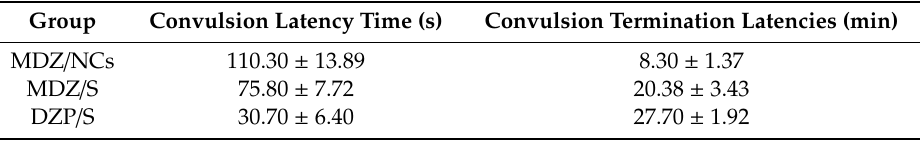
Table 7. Summary of the anticonvulsant e ff ects of the MDZ treatment in the MST model.